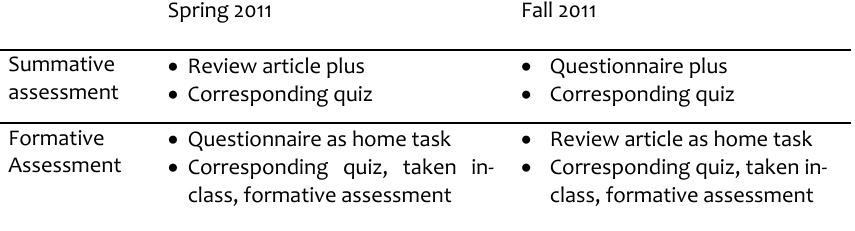
Table 1: Administration schema for